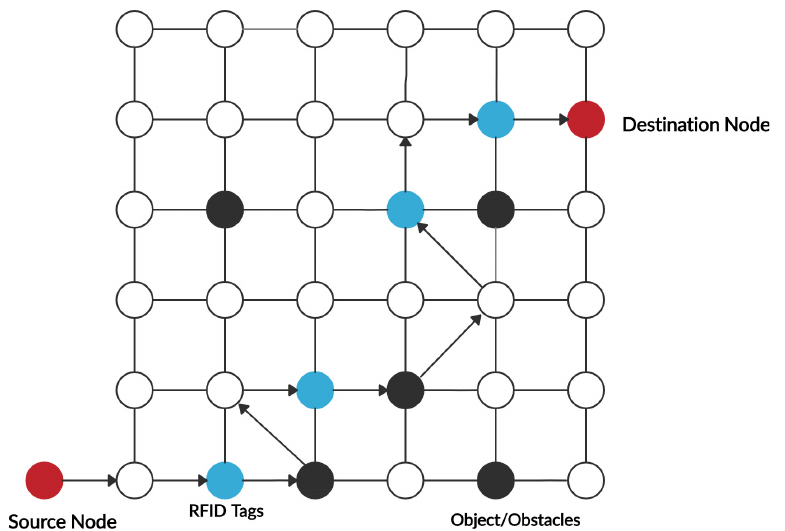
Fig. 2. Path following implementation using vector mapping and